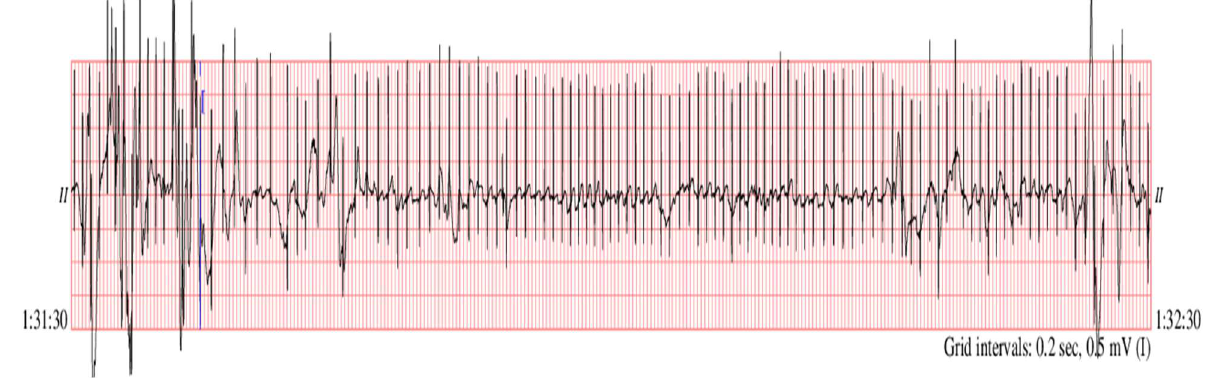
Figure 4. Original ECG named infant6_ecgm , after 1 h, 31 min and 30 s of standard recording (https://archive.physionet.org/cgi-bin/atm/ATM (accessed on 29 August 2021).